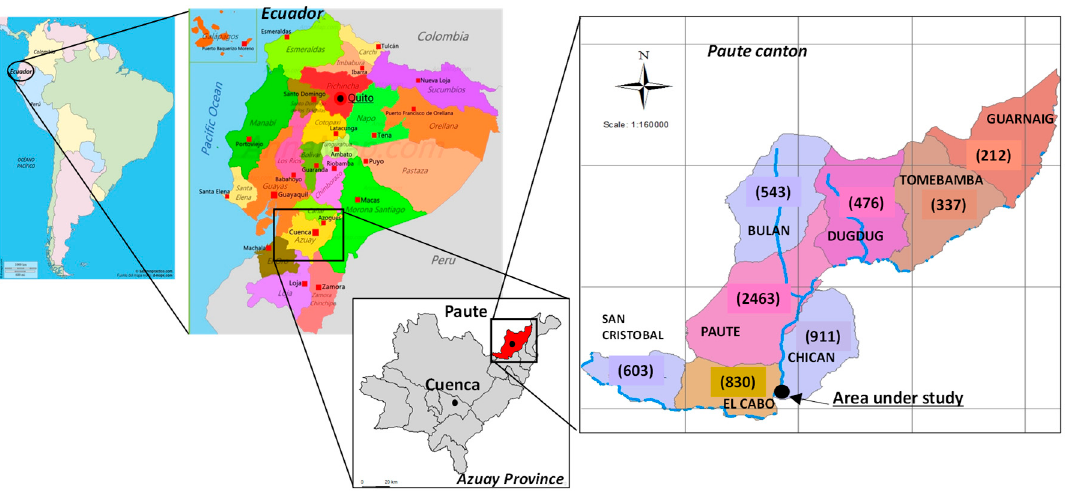
Figure 1. The study area in the Paute canton and the corresponding resident families (in brackets) for the eight different zones.